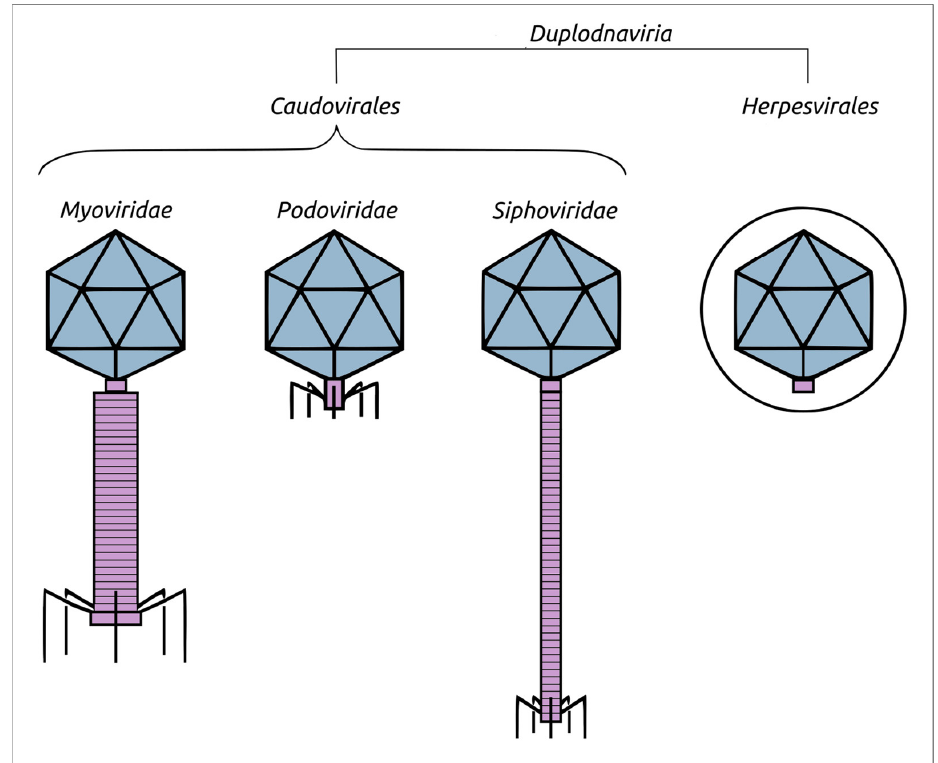
Figure 1. Schematic representation of the morphology of phages belonging to the former Caudovirales order, namely, the Myoviridae , Podoviridae , and Siphoviridae families, along with the evolutionarily related herpesviruses wrapped in the tegument, which is depicted as a circle. Viral capsids are coloured in slate, while tails and portal–vertex complexes are purple.